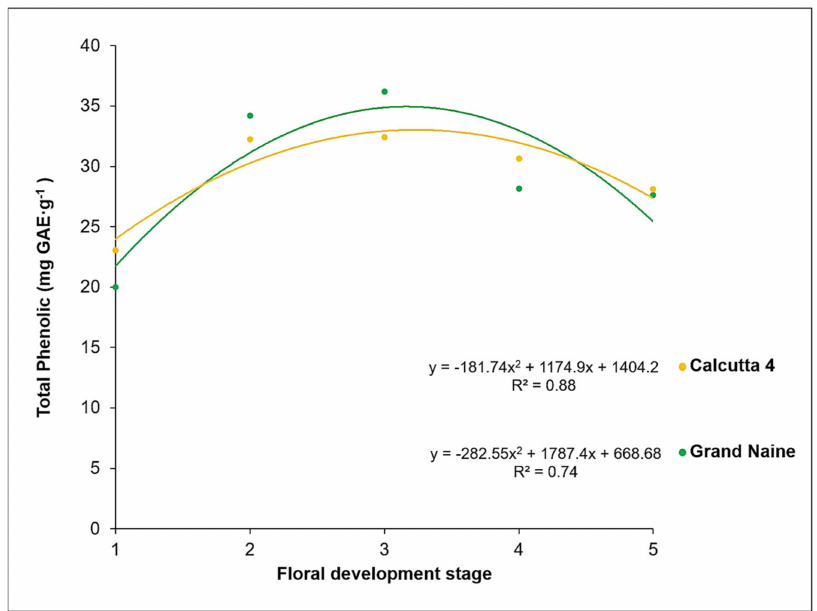
Figure 1. Total phenolic content at different floral developmental stages of the nectary of Calcutta 4 and Grand